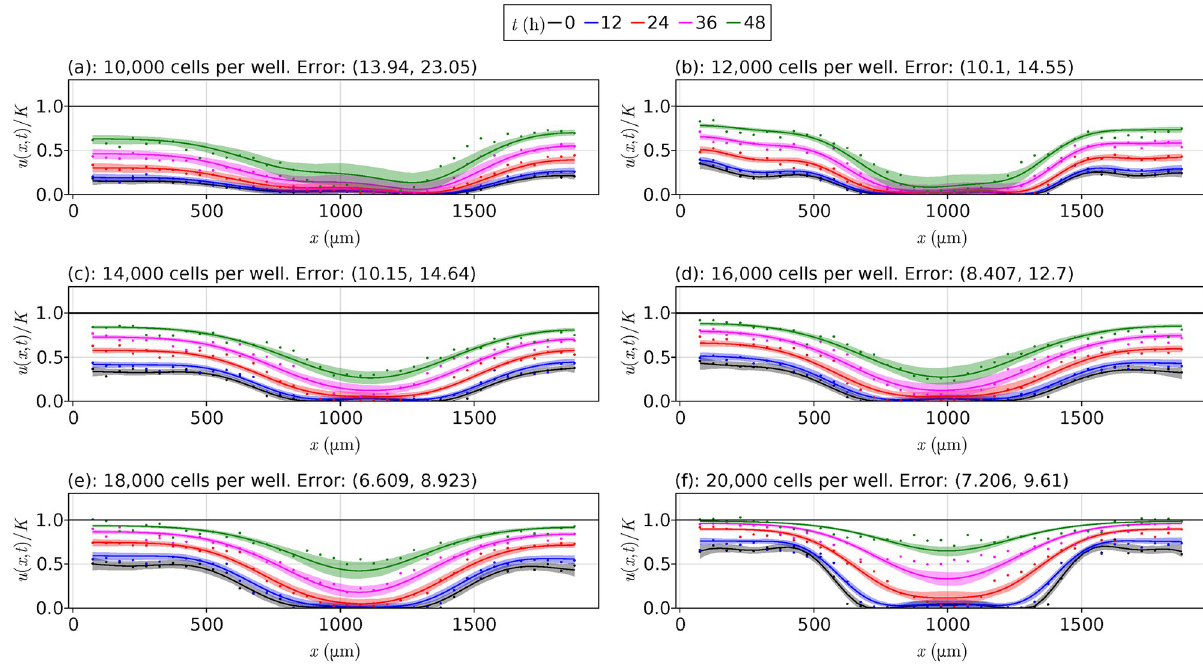
Fig 6. Optimal results for each data set. PDE solutions for each data set from Jin et al. [13] for the delayed Fisher-Kolmogorov model (3) from Table 1, with the vertical axis giving u / K rather than u , where K = 1.7 × 10 − 3 cells μ m − 2 . The points show the data from Jin et al. [13], the solid lines show the mean solution at each corresponding time, and the shaded regions around these lines give the 95% confidence intervals for each solution. Initial conditions are obtained from sampling the Gaussian process rather than using splines. The black horizontal line is at u / K = 1.